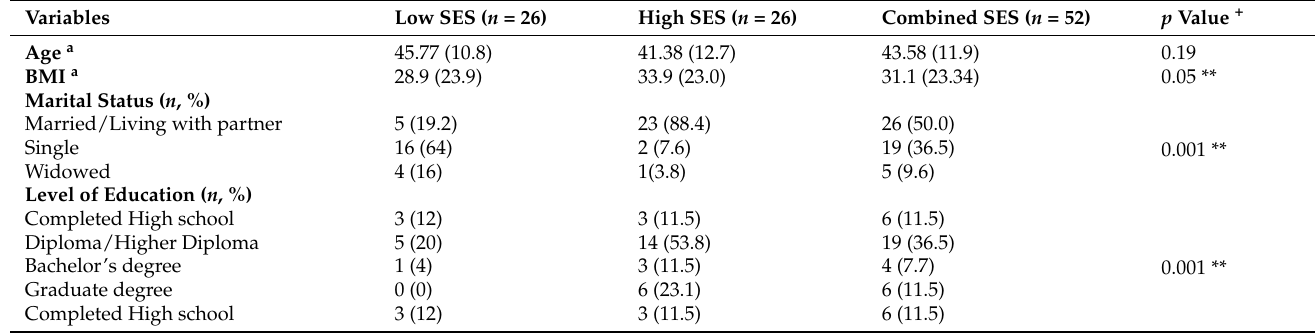
Table 1. Descriptive statistics for participants’ demographics SES